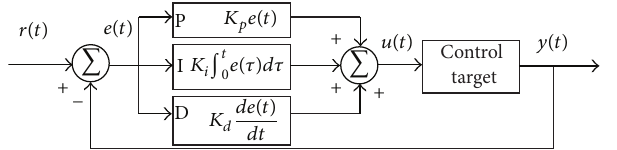
Figure 3: Block diagram of a PID controller in a feedback loop.